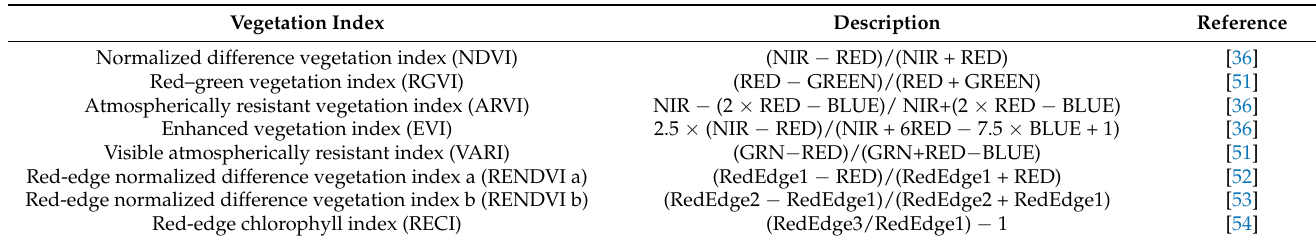
Table 4. List of vegetation indices (VI) used in this